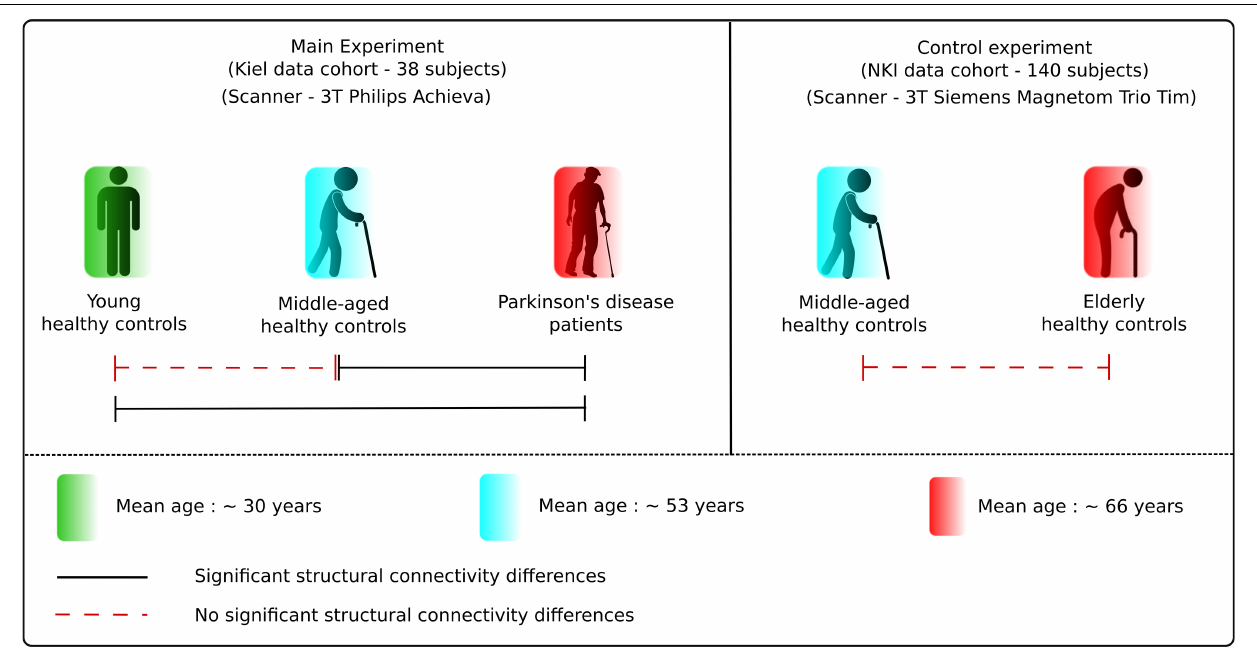
FIGURE 6 | Results summary. The figure illustrates the main results obtained in the study. There was no significant difference between the healthy subject groups but significant differences between the healthy and PD patients group, presenting the clear delineation in aging and